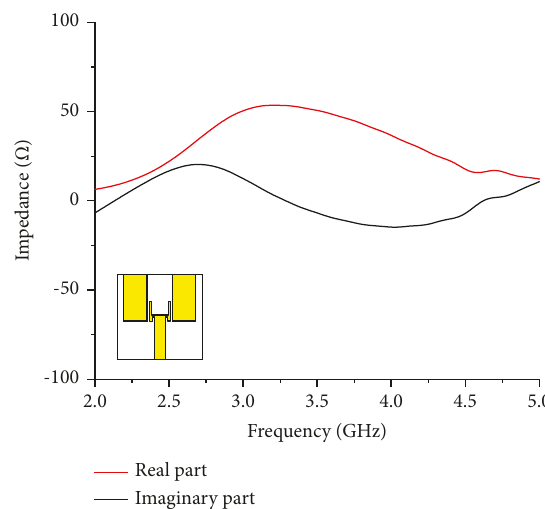
Figure 14: Z parameters of the MPA. Figure 13: Radiation efficiency of the